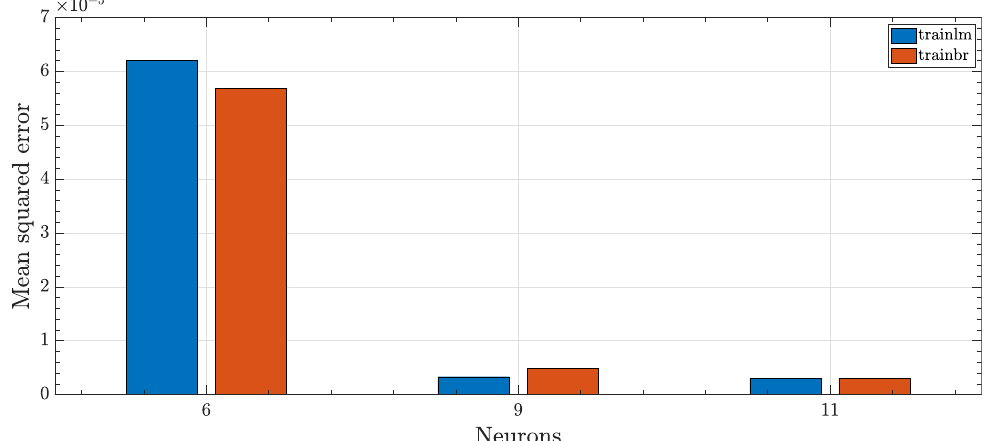
Figure 11. Single hidden layer networks performance as function of neurons and training function, sampling mode 2.